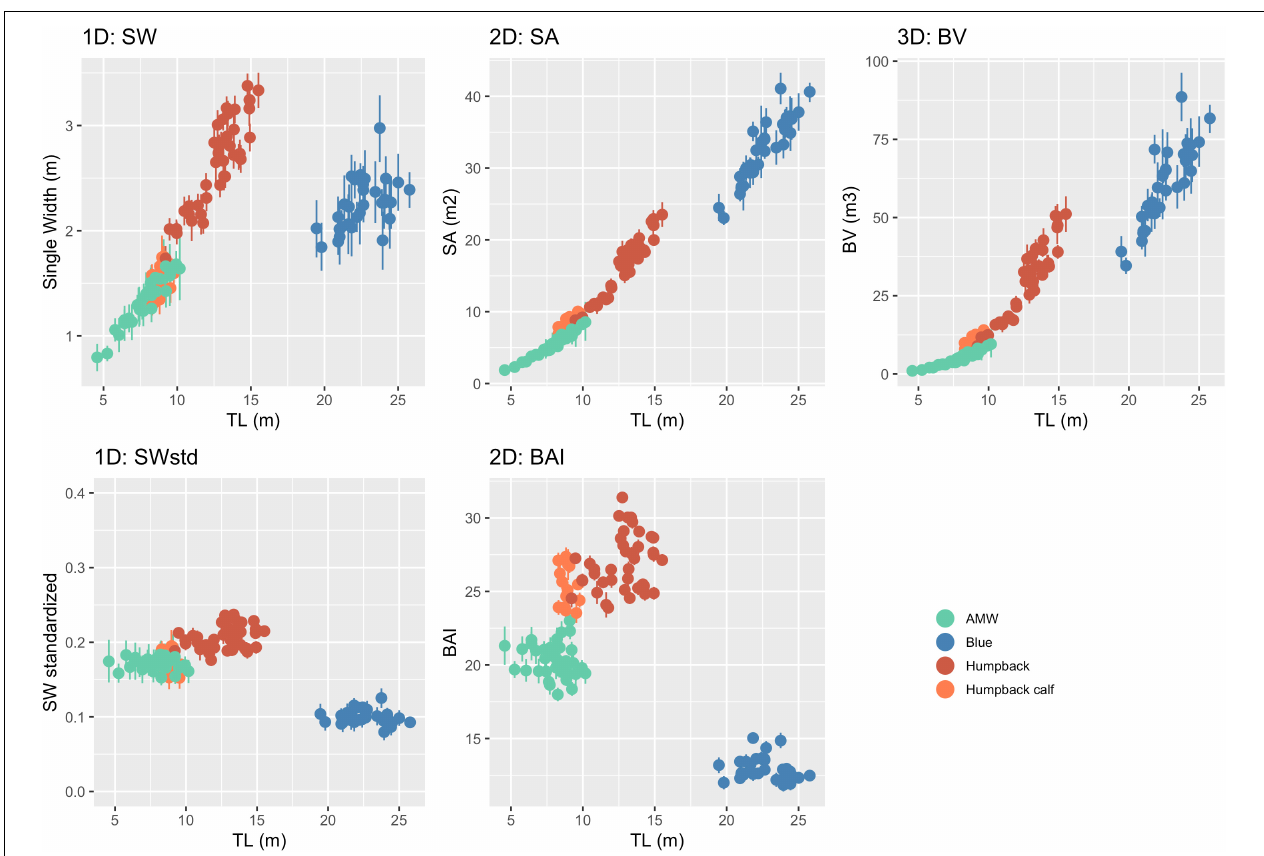
FIGURE 4 | One-dimensional (1D), 2D, and 3D body condition measurements with uncertainty. Each point represents the mean of the posterior predictive distribution of that body condition measurement with the bars representing the lower and upper bounds of the 95% HPD interval for that specific individual whale (represented in Figure 3 ). Unstandardized measurements are in the top three panels, while the bottom two panels are standardized versions of 1D and 2D